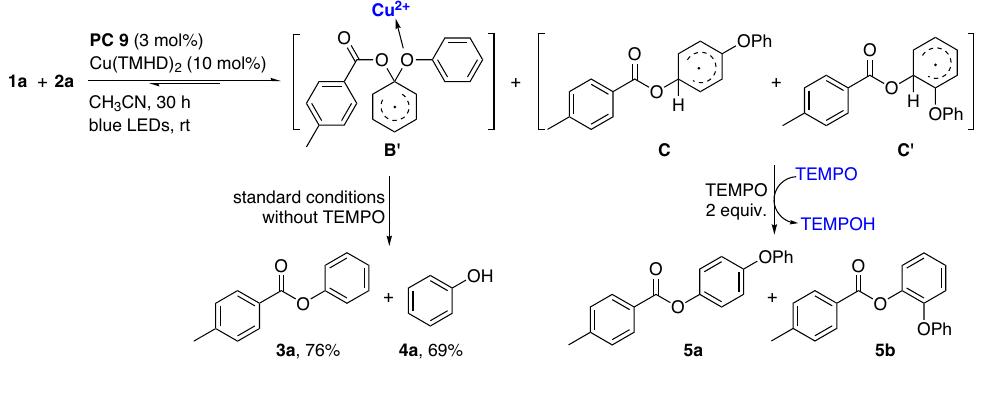
Fig. 7 Deducing possible intermediate B ′ a . With the addition of 2 equiv. of TEMPO as oxidant, compounds 5a and 5b , instead of 3 and 4 , were obtained. This result and the standard reaction suggest that the reaction of 1a with 2a generates possible intermediate B ’ .